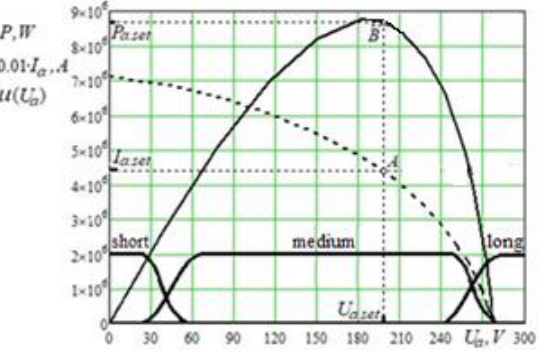
Figure 3. Characteristics I a ( U a ) and P a ( U a ) of DSP-200 furnace and membership functions µ ( U a ) of the input linguistic variable U a of fuzzy inference systems FIS2.